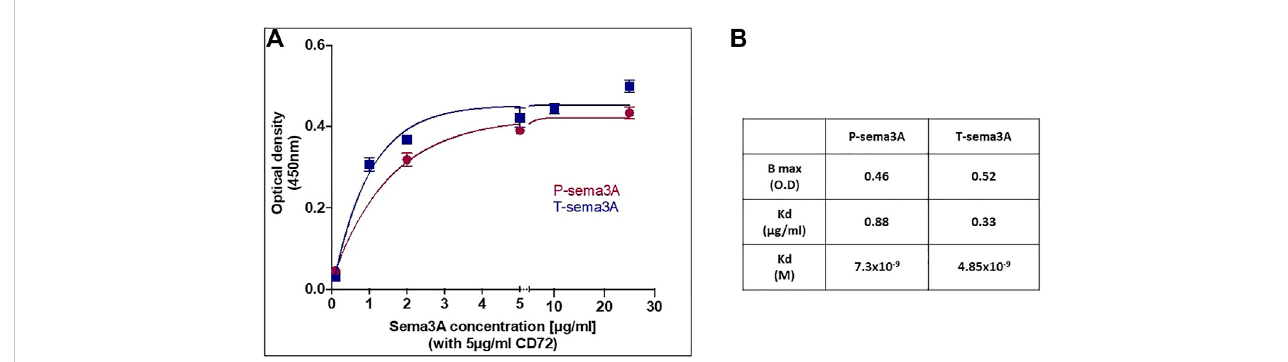
FIGURE 3 Truncated sema3A can interact with CD72 (A) . The ELISA plate was coated with 5 μ g/mL puri fi ed CD72 and increasing concentrations of puri fi ed P-sema3A or T-sema3A were added (0-25 μ g/mL). Followed by polyclonal goat anti-human semaphorin3A antibody (directed against the N-terminal of sema3A (26-771 amino acids), then by anti-goat horseradish peroxidase antibody, TMB-Plus substrate chromogen, and a stop solution (10% H2SO4). The opticaldensity(O.D.)wasmeasuredat450nmand360 nmusinganELISAreaderandGen5software,andtheO.D.ofeachsamplewascalculatedasO.D. sample minus O.D. background (O.D. background = 0.073). The binding curves representing the optical density as a function of P- or T-sema3A concentration were drawn using GraphPad Prism software. (B) . The Kd (equilibrium dissociation constant) and Bmax (maximal binding) were analyzed according to one site total binding equation using GraphPad Prism software.